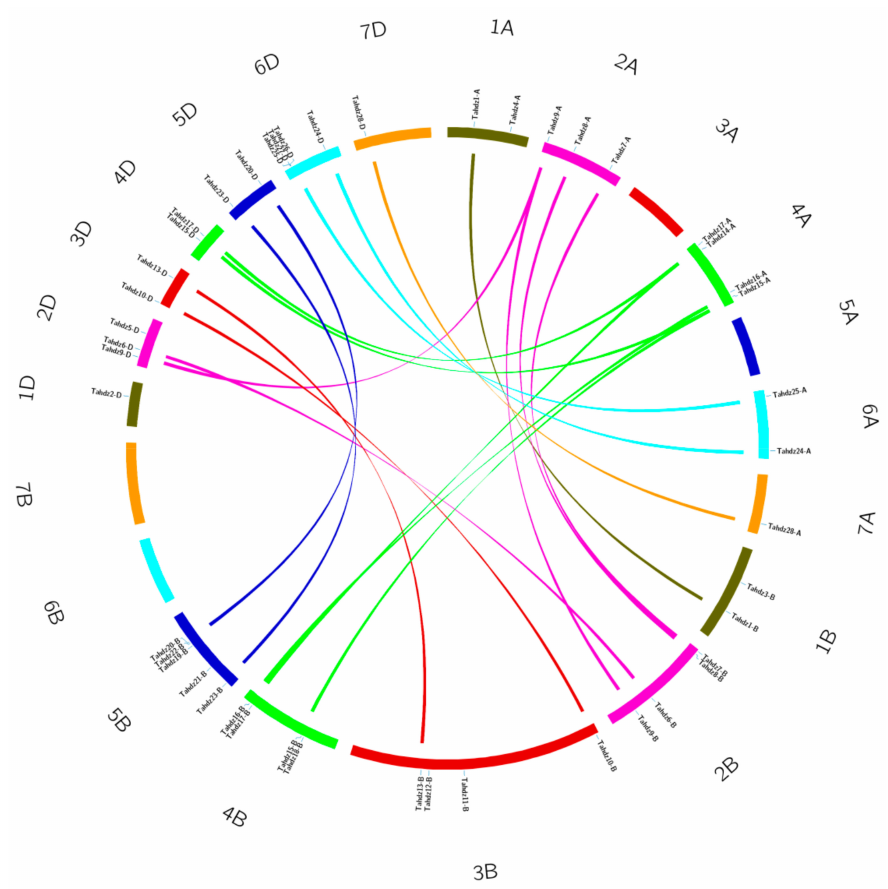
Figure 1. Chromosomal localization and gene duplication identified in wheat. Seven chromosomes of wheat A, B and D sub-genomes are displayed in different colors. Duplicated gene pairs are exhibited in linked lines with the corresponding